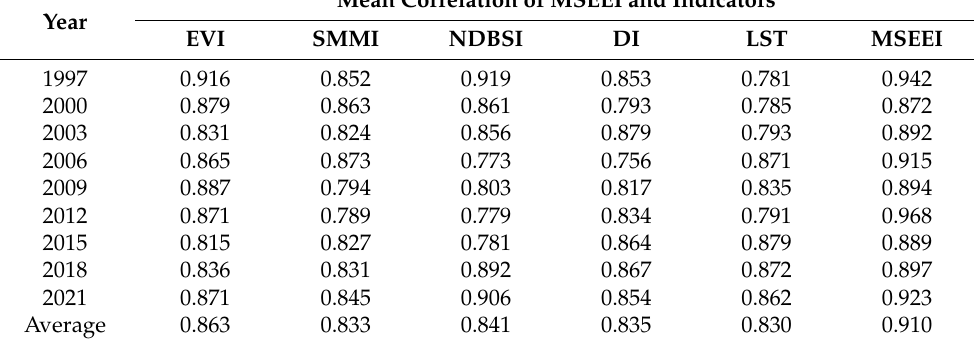
Table 1. Mean correlations of the MSEEI and indicators.